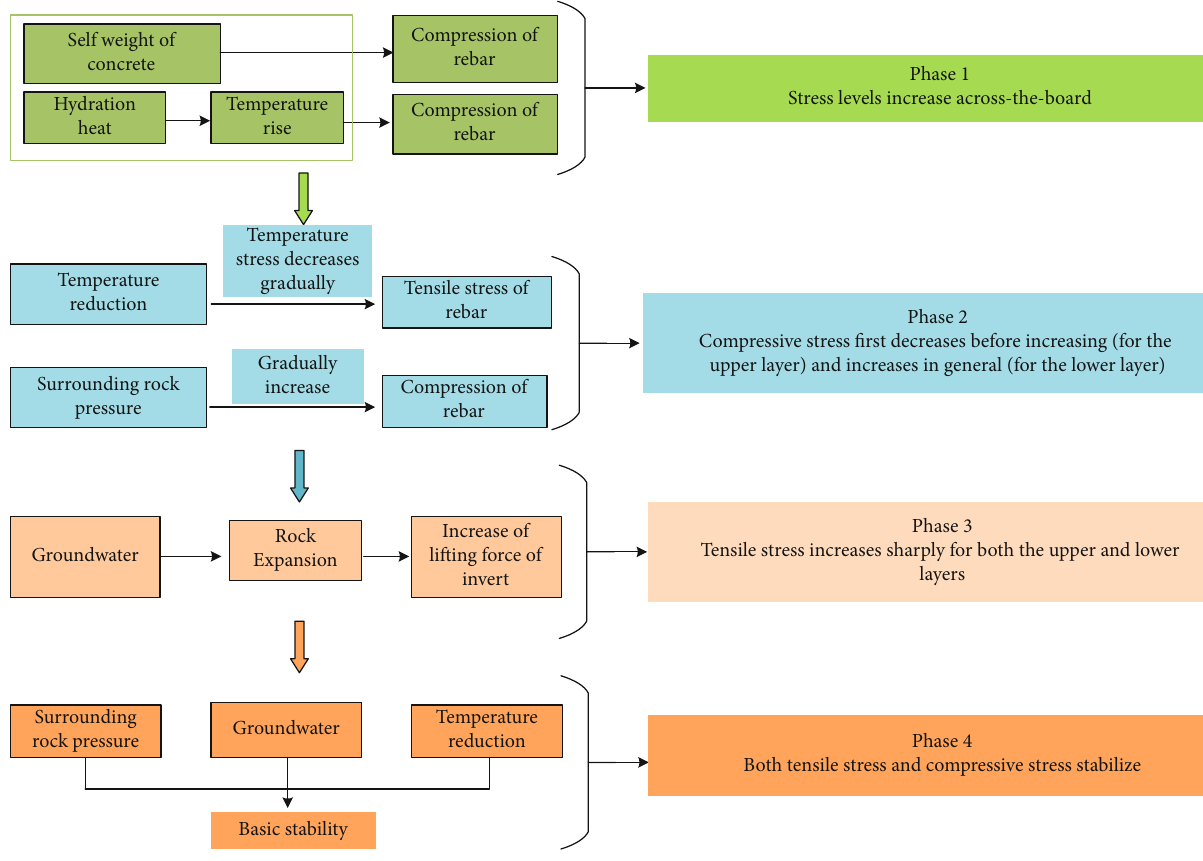
Figure 12: Process for how compressive stress acts on rebar in enriched water tunnel